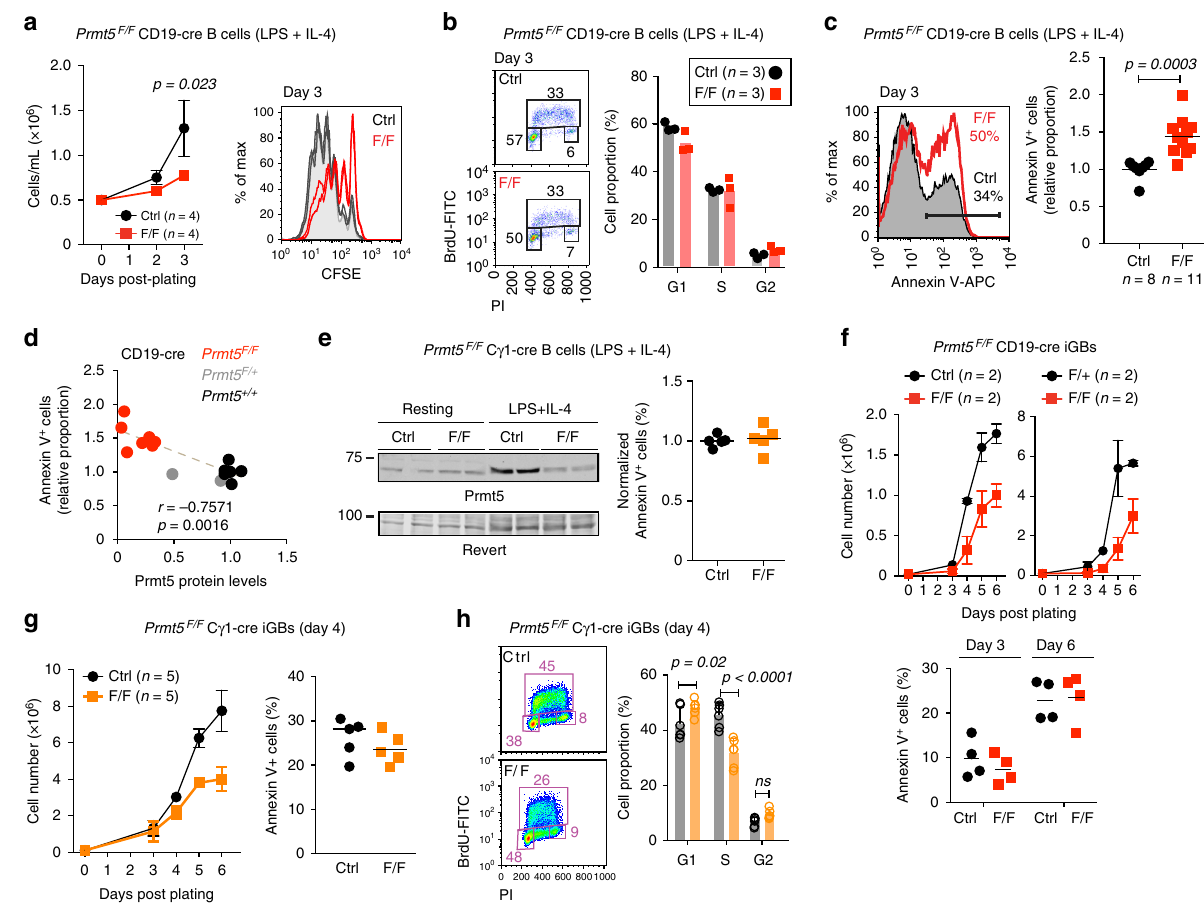
Fig. 3 Prmt5 protects B cells from apoptosis and promotes proliferation. a – d One million naïve splenic B cells from CD19-cre (Ctrl) and Prmt5 F/F CD19-cre (F/F) mice were plated with LPS (5 µ g/mL) + IL-4 (5 ng/mL). a Cell expansion over time monitored by cell counting (left) and number of cell divisions by day 3 monitored by CFSE stain dilution (right) from two experiments, four mice per genotype. b Cell cycle pro fi le of cells pulsed with BrdU at day 3 before staining with anti-BrdU and propidium iodide (PI). Data for three mice (symbols) per genotype and means (bars) from one experiment are plotted. c Representative Annexin-V + staining histograms of B cells 3 days post-plating. The proportion of Annexin-V + cells for individual mice (symbols) and means (bars) from fi ve experiments are plotted normalized to the Ctrl mean. d Proportion of Annexin-V + B cells as a function of Prmt5 protein levels measured by WB and normalized to Actin 72 h post-stimulation. Spearman ’ s correlation coef fi cient ( r ) and p -value ( p ) are indicated. e WB of Prmt5 and Revert protein staining as loading control in extracts of splenic B cells from C γ 1-cre (Ctrl) and Prmt5 F/F C γ 1-cre (F/F) mice, stimulated as in a for 72 h. The normalized proportion of Annexin-V + cells for individual mice (symbols) from three experiments and mean values (bars) are plotted. f Top, resting splenic B cells from Prmt5 F/ + CD19-cre (Ctrl) or Prmt5 F/F CD19-cre (F/ + ) and Prmt5 F/F CD19-cre (F/F) mice plated onto 40LB cells with 1 ng/mL IL-4 to generate GC-like B cells (iGBs). Mean ± s.e.m. cell counts per day are plotted for two experiments with two mice each. Bottom, proportion of Annexin-V + iGBs for individual mice (symbols) and means (bars) for both experiments are plotted, pooling + / + and F/ + as controls. g C γ 1-cre (Ctrl) and Prmt5 F/F C γ 1-cre (F/F) mice iGBs analyzed as in f . h Representative cell cycle pro fi le as in b in C γ 1-cre (Ctrl) and Prmt5 F/F C γ 1-cre (F/F) iGBs at day 4. Means + s.d. of six mice per genotype from three experiments are plotted. Unpaired, two-tailed Student's t test was performed in a , c , e – g , only signi fi cant p -values are